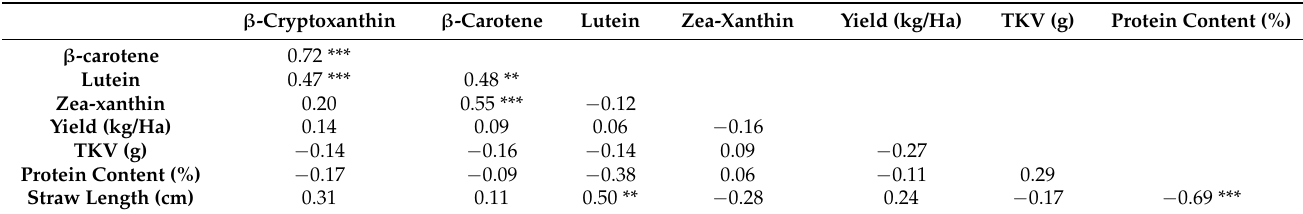
Table 4. Pearson correlation coefficients for content of various carotenoids and plant parameters of locally and organically produced